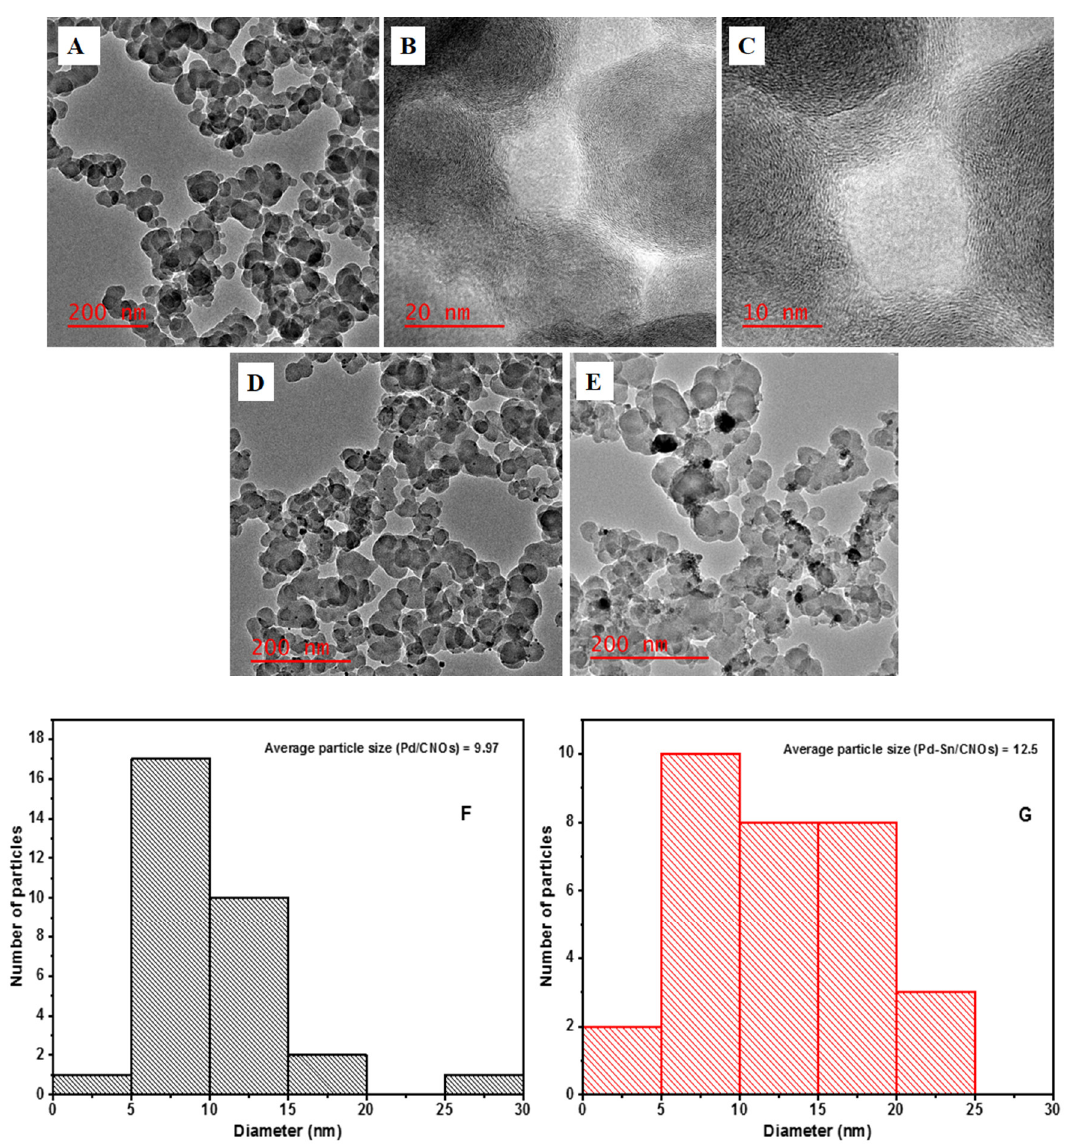
Figure 2. HR-TEM images of carbon nano-onion supports with different magnifications ( A – C ), Pd/CNO electro-catalysts, ( D ) and Pd-Sn/CNO electro-catalysts ( E ); average particle size of Pd NPs in Pd/CNOs ( F ) and Pd-Sn/CNOs ( G ).